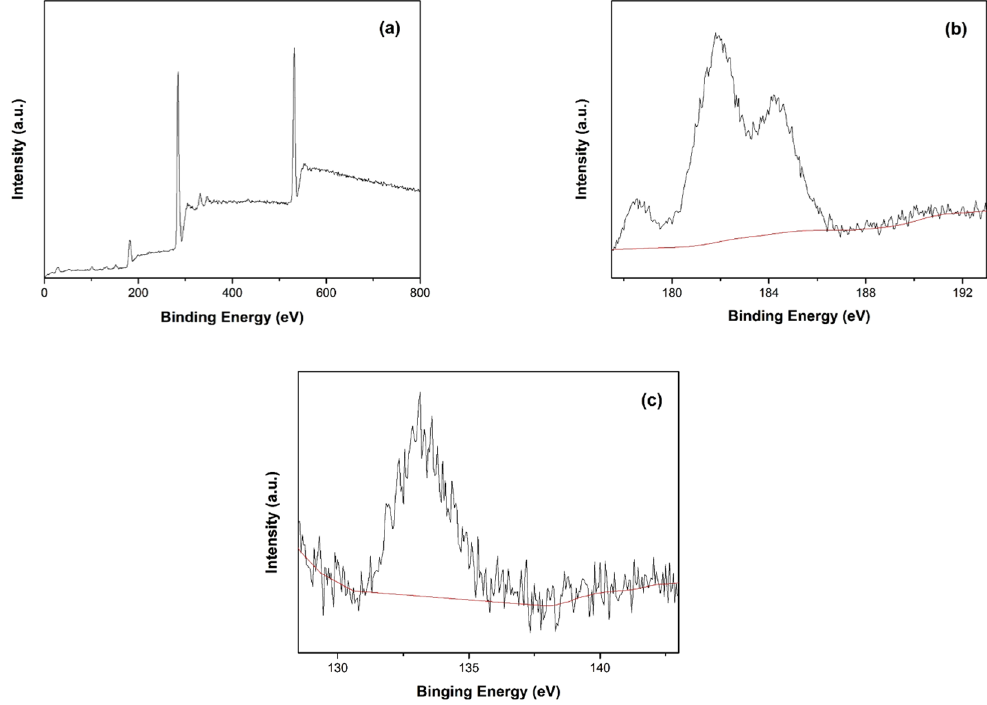
Figure 3. XPS analyses of the ZrP sample. ( a ) survey spectrum ( b ) Zr3d region ( c ) P2p region.